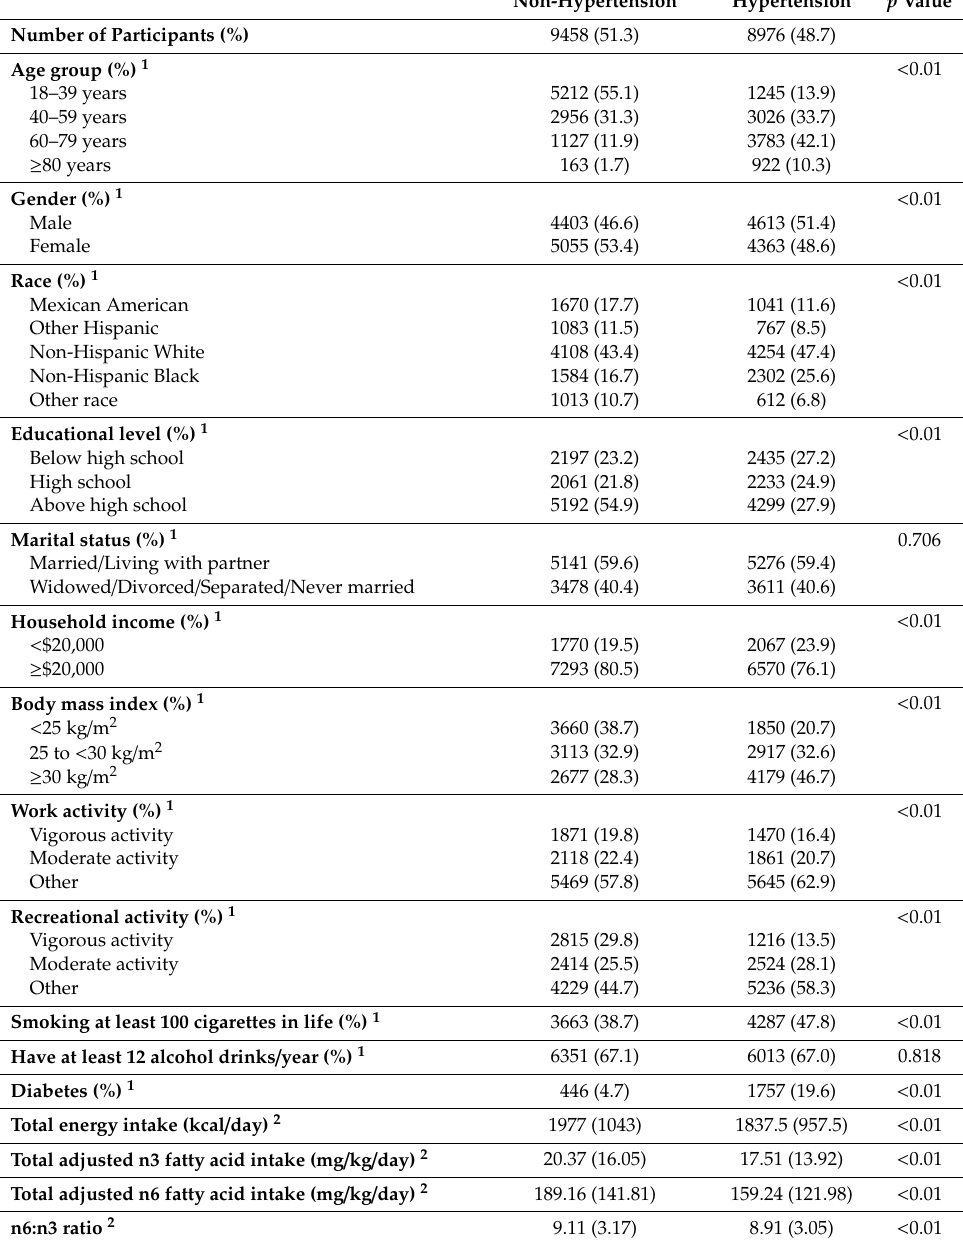
Table 1. Characteristics of participants by hypertension, NHANES 2007–2014 ( N =